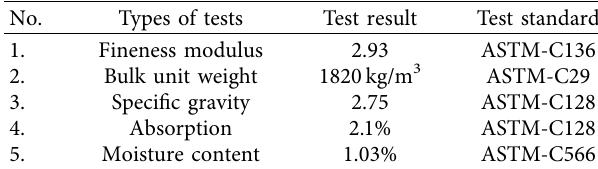
Table 5: Physical properties of fine